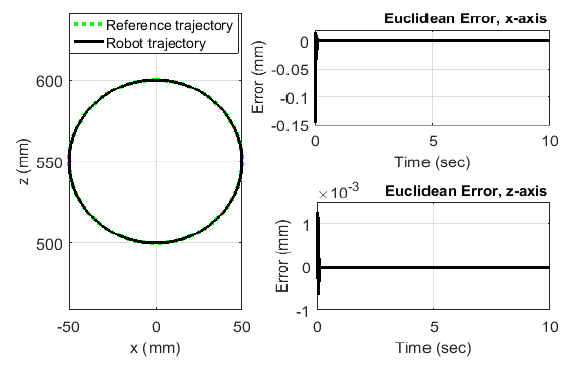
Figure 7. Actual and reference trajectories and the Euclidean errors between them using the dynamic model